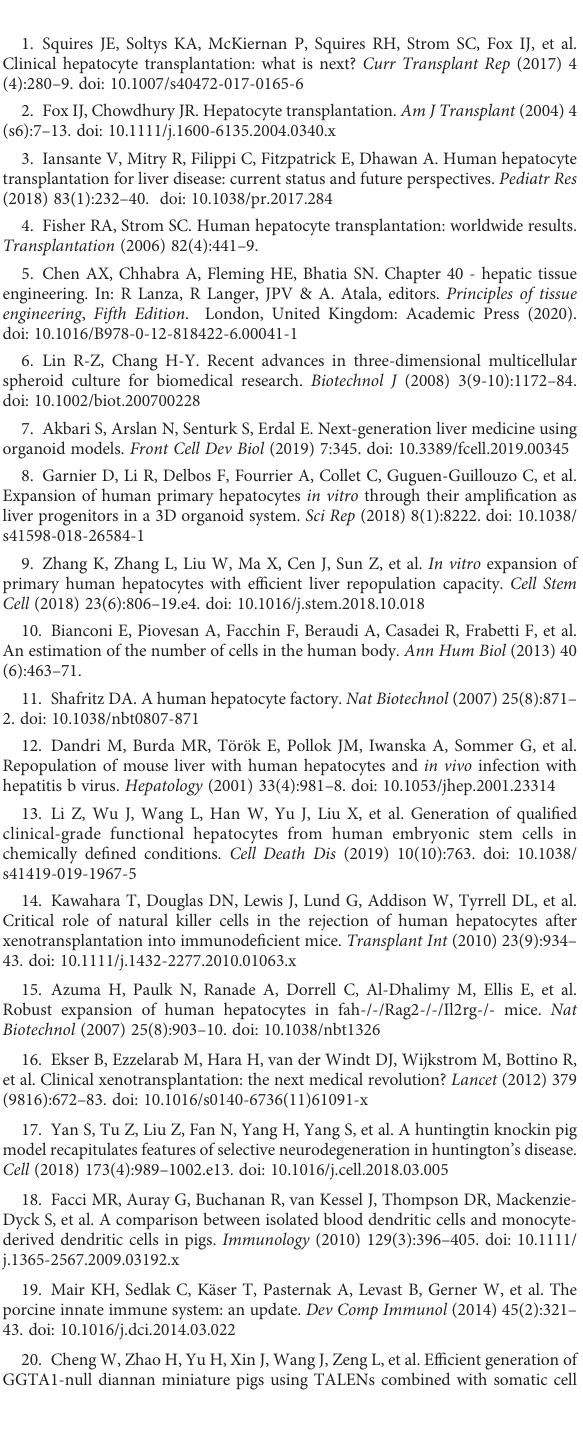
SUPPLEMENTARY TABLE 5 Primer sequences used for V(D)J rearrangement detection. SUPPLEMENTARY TABLE 6 Biochemical function of